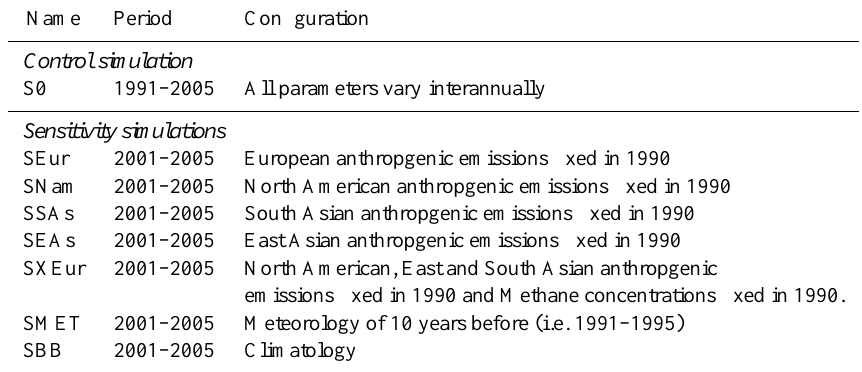
Table 1. Simulations performed with the GEOS-Chem model in the present